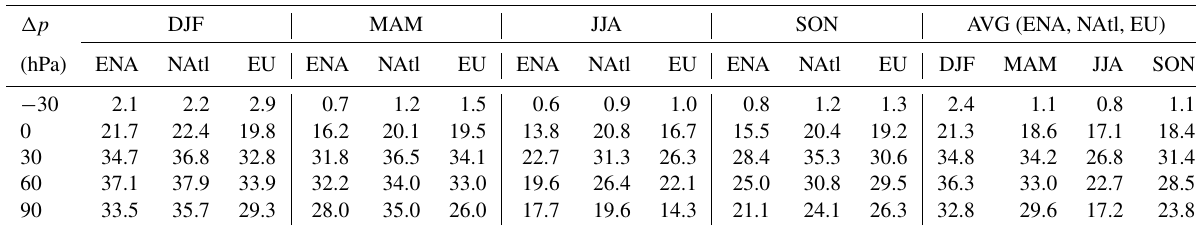
Table 1. ISSR frequency of occurrence: seasonal mean values are reported in percentages; the vertical distance to the thermal tropopause is reported as (cid:49)p = p layer − p therm.TPH .